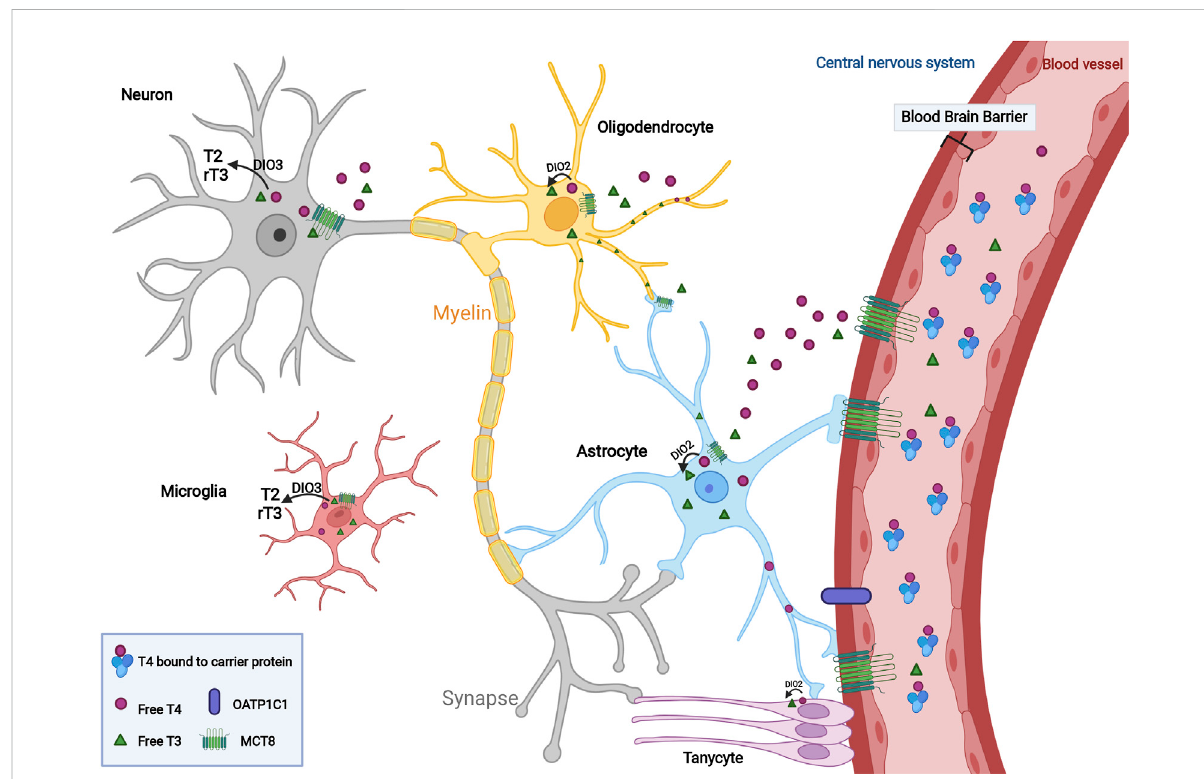
FIGURE 1 Transport and regulation of thyroid hormone within the central nervous system. In the circulation, a higher ratio of TH is in the form of free T4 compared to T3level, whichis sustained inan inactive status due to its binding with carrier proteinsuch as albumin. T4 and T3cross the blood-brain barrier (BBB) via the monocarboxylate transporter 8 (MCT8) and OATP1C1 and then transported into neurons and glial cells including astrocytes, oligodendrocytes, microglia and tanycytes within the CNS. To promote cellular proliferation, differentiation and myelination mediated by TH, T4convertstoitsactiveform,T3,inthepresenceofdeiodinasetype2(DIO2).ActiveT3mediatesmyelinationbymatureoligodendrocytes.Increased thyroidhormoneconcentrationscontributetotheconversionofT3andT4toinactivemetabolites,T2andrT3,tomaintainendogenoushomeostasis under the regulation of